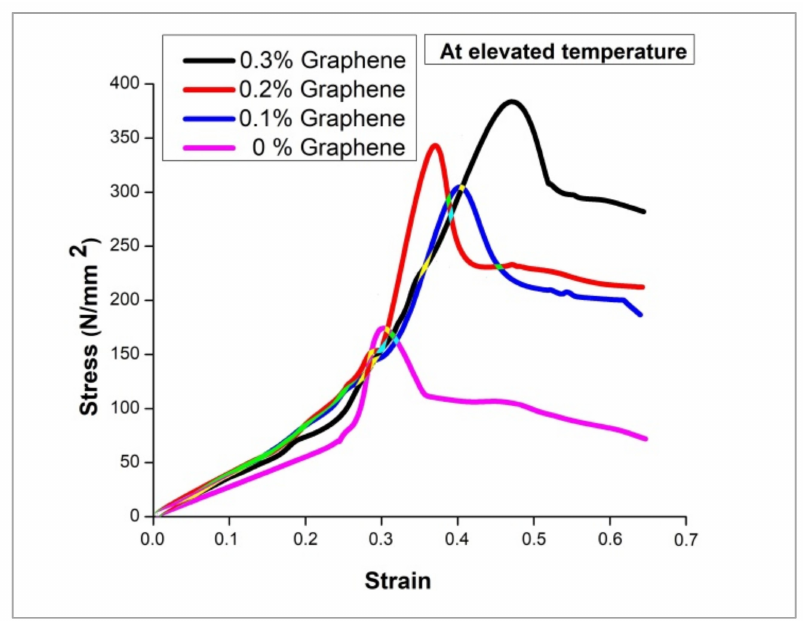
Figure 11. Engineering stress-strain plot at elevated